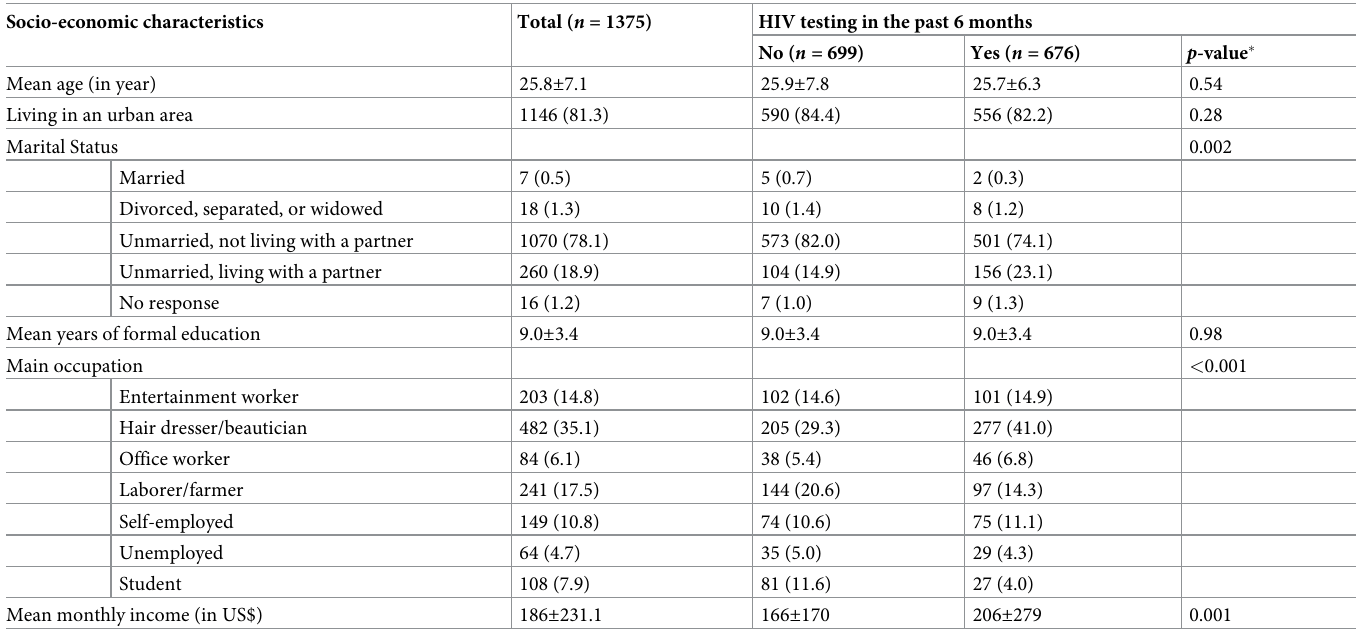
Table 1. Comparisons of characteristics of transgender women who had and who had not tested for